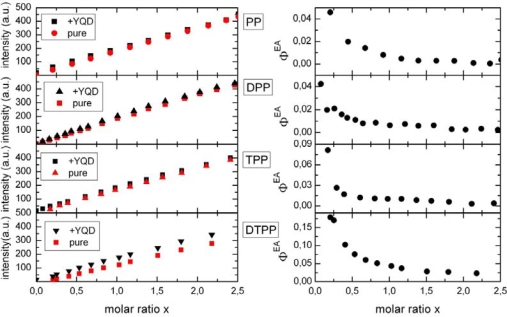
Fluorescence enhancement of PBI dyes by YQD. The left side shows the dye fluorescence intensities F without (pure) and as a function of the molar ratio x (cPBI/cYQD), whereat cYQD was kept constant at 100 nM. On the right side we have plotted ΦEA (Equation 2).